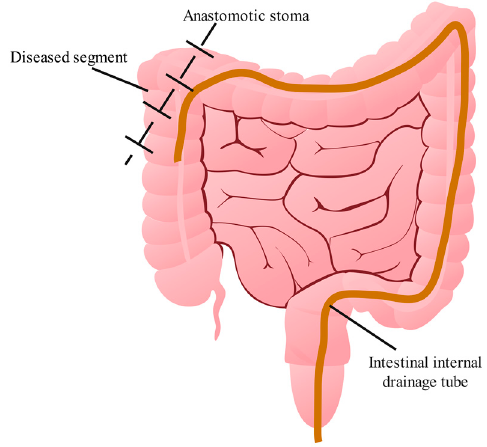
Figure 1. Schematic diagram of modified primary anastomosis.